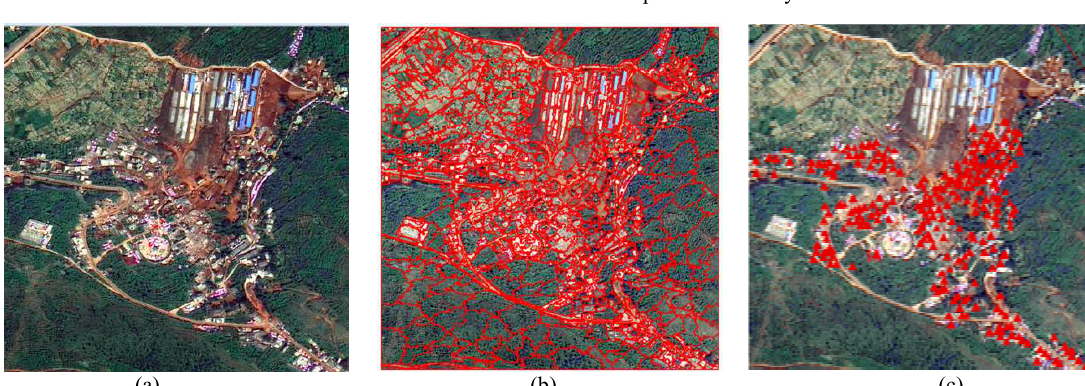
Figure 2. Images of the experimental area: (a) original image;(b)segmented map;(c) sample